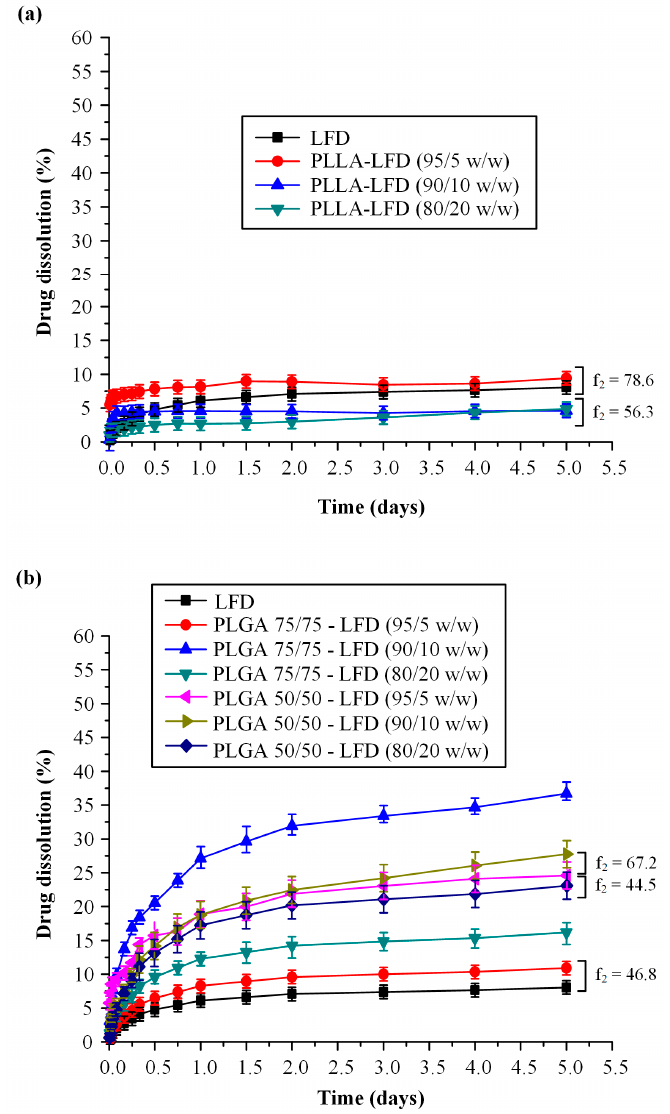
Figure 10. Dissolution release profiles in pH 7.4 of neat LDF-loaded PLLA ( a ) and PLGA ( b ) thin-film patches. Similarity factors ( f 2) results between the several dissolution profiles are also de- picted.